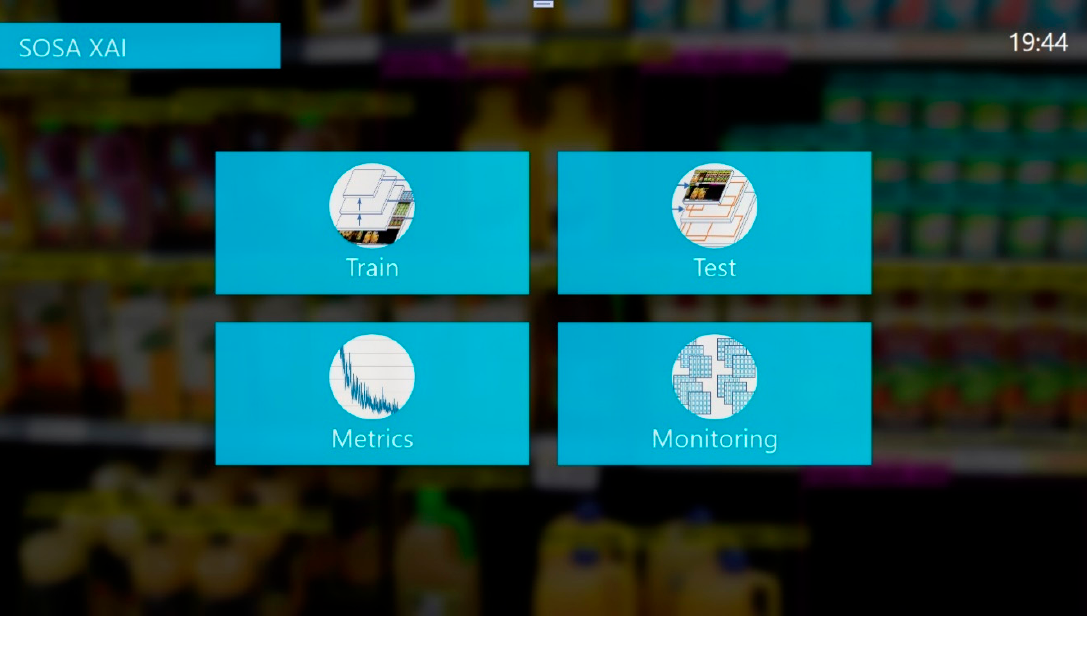
Figure 3. The main screen of SOSA XAI.